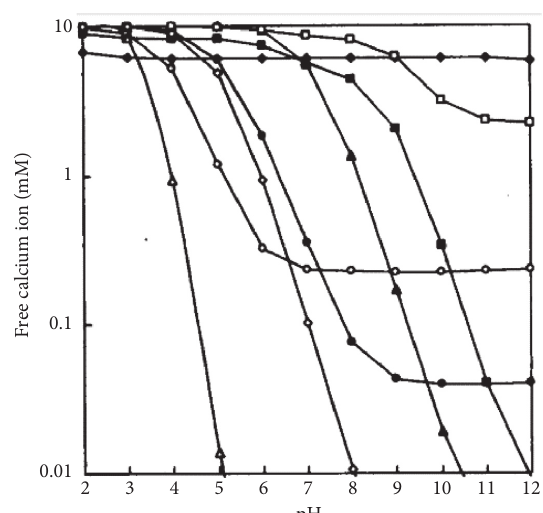
Figure 11: Concentration of free calcium dissolved by various chelators under different pH conditions. Symbols: sulfate ( ◆ ), nitrilotriacetic acid ( ◊ ), EDTA ( ⌂ ), carbonate ( □ ), citrate ( ○ ), orthophosphate ( █ ), diphosphate ( ● ), and tripolyphosphate ( ▲ )